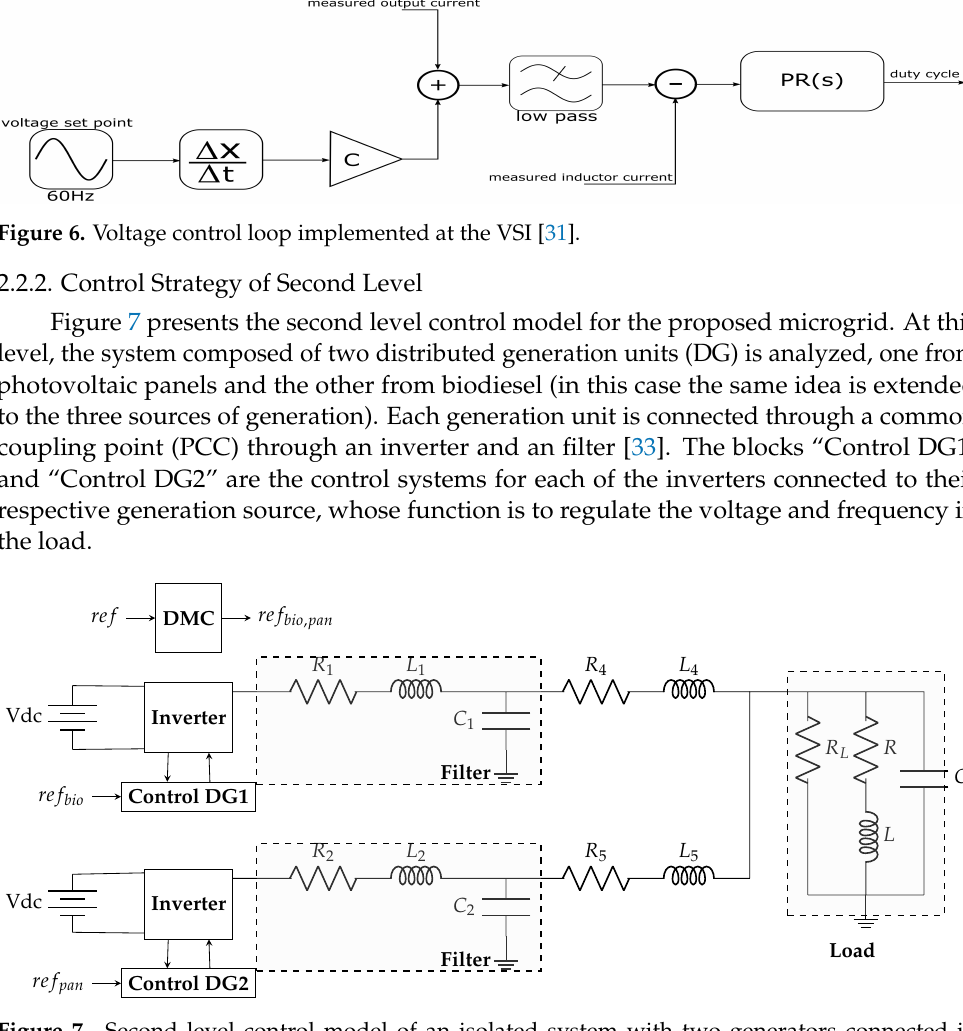
Figure 7. Second level control model of an isolated system with two generators connected in parallel